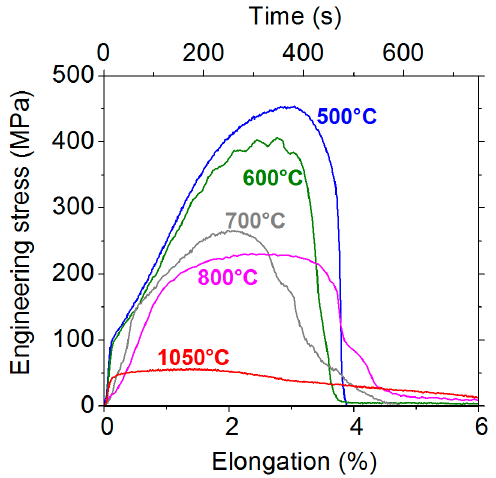
Figure 3: The engineering stress–strain curves of the 9 ppm S material at different temperatures. Figure 3. The engineering stress–strain curves of the 9 ppm S material at di ff erent